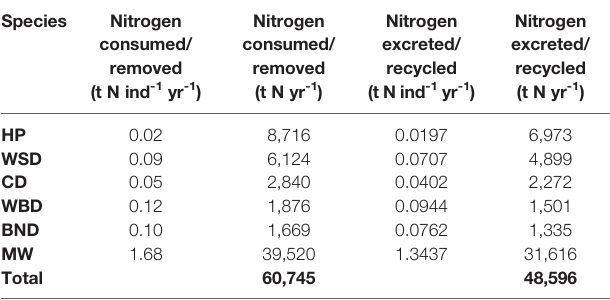
TABLE 4 | Cetacean driven nitrogen fl uxes. Species Nitrogen consumed/ removed (t N ind -1 yr -1